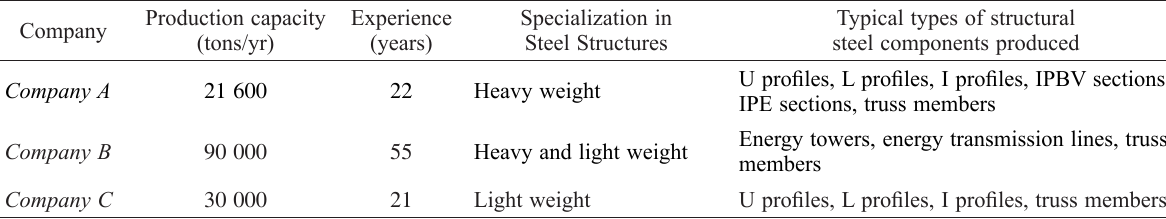
Table 2. General profile of the companies that participated in the study Company